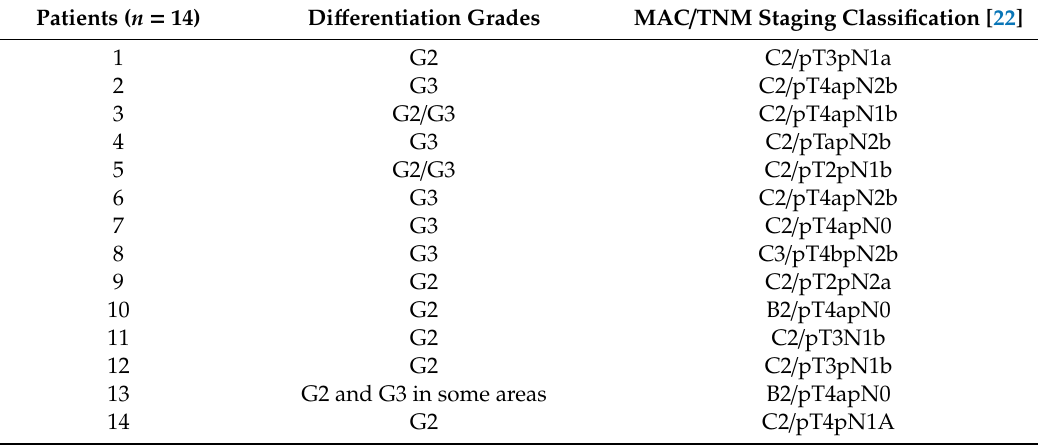
Table 1. Oncologic characteristics of colorectal cancer (CRC) surgery patients. Patients ( n =